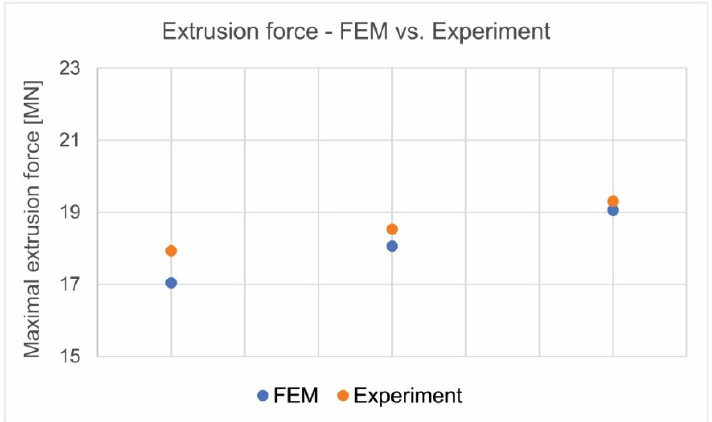
Figure 29. Comparison of extrusion force for the analysed tube from 7021 alloy—FEM predicted and experimentally validated.